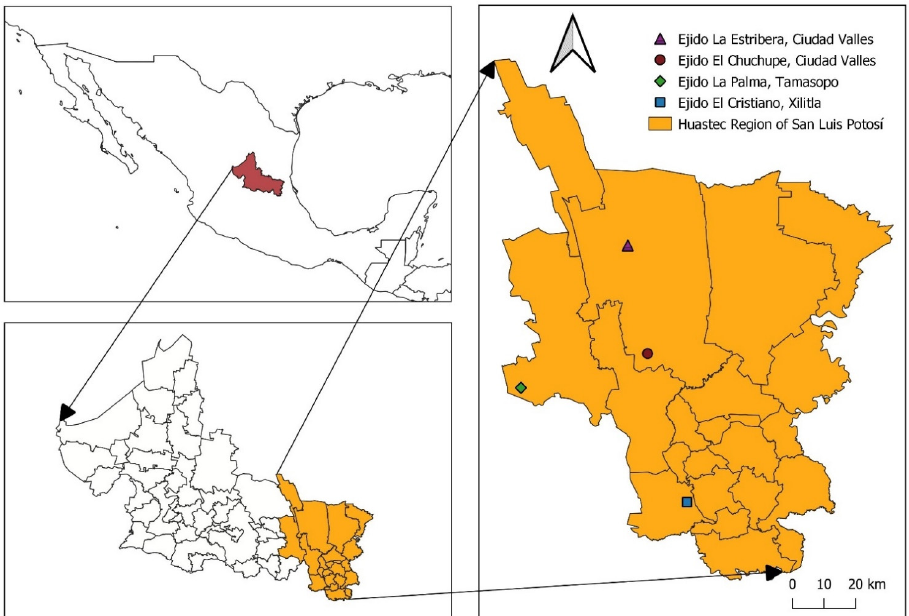
Figure A1. Map of Huasteca Potosina Region and the Locations of the Four Case Studies. Source: prepared by author SLV, May, 2022.